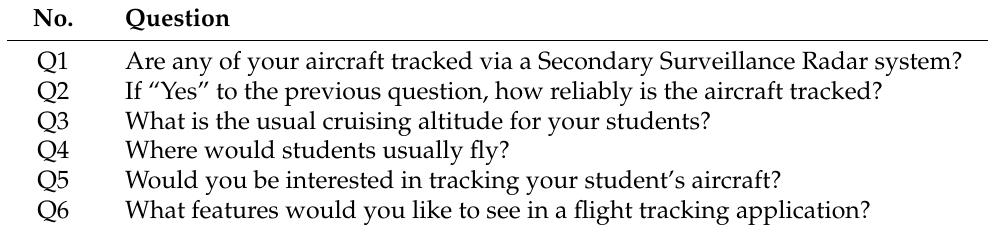
Table 3. Interview questions with the flight